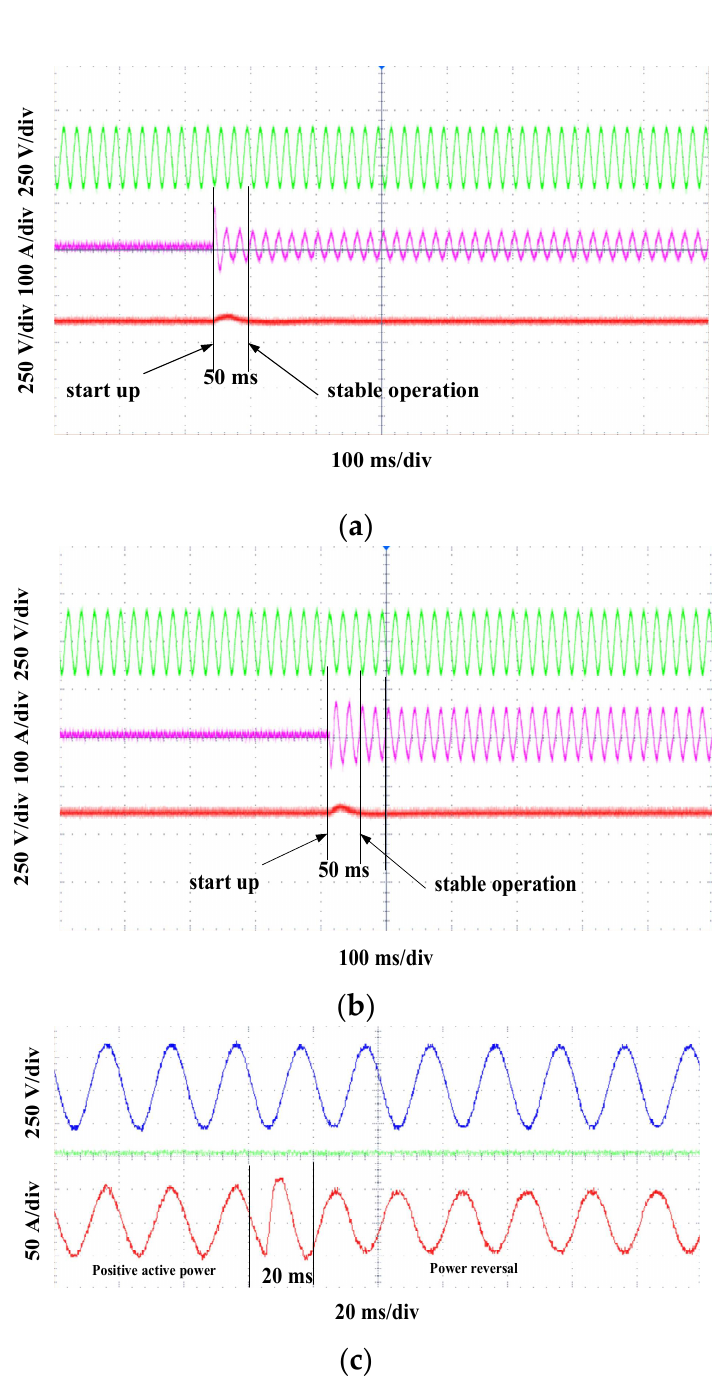
Figure 16. Double module power cycle test: ( a ) Power voltage, module current and DC voltage (10 kW); ( b ) Single-phase average active power control block diagram (25 kW); ( c ) Power voltage and module current (20 kW).